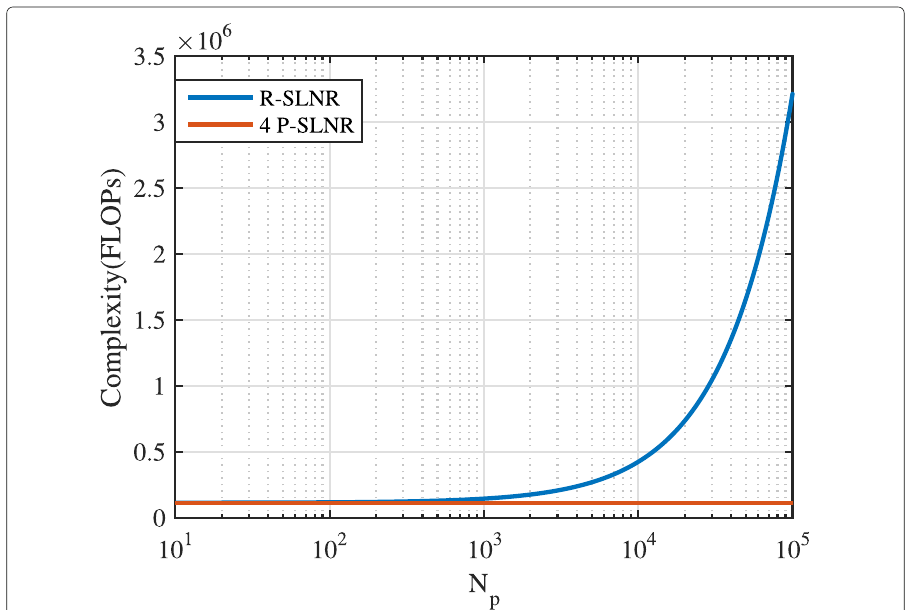
Fig. 2 The complexity versus the integral points N p of the proposed